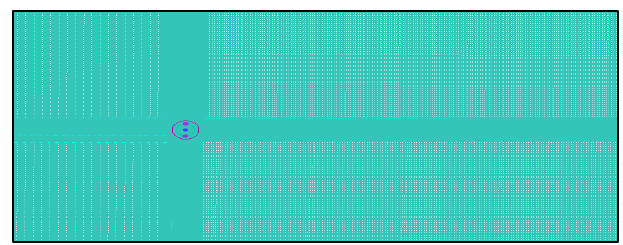
Figure 5. CFD domain